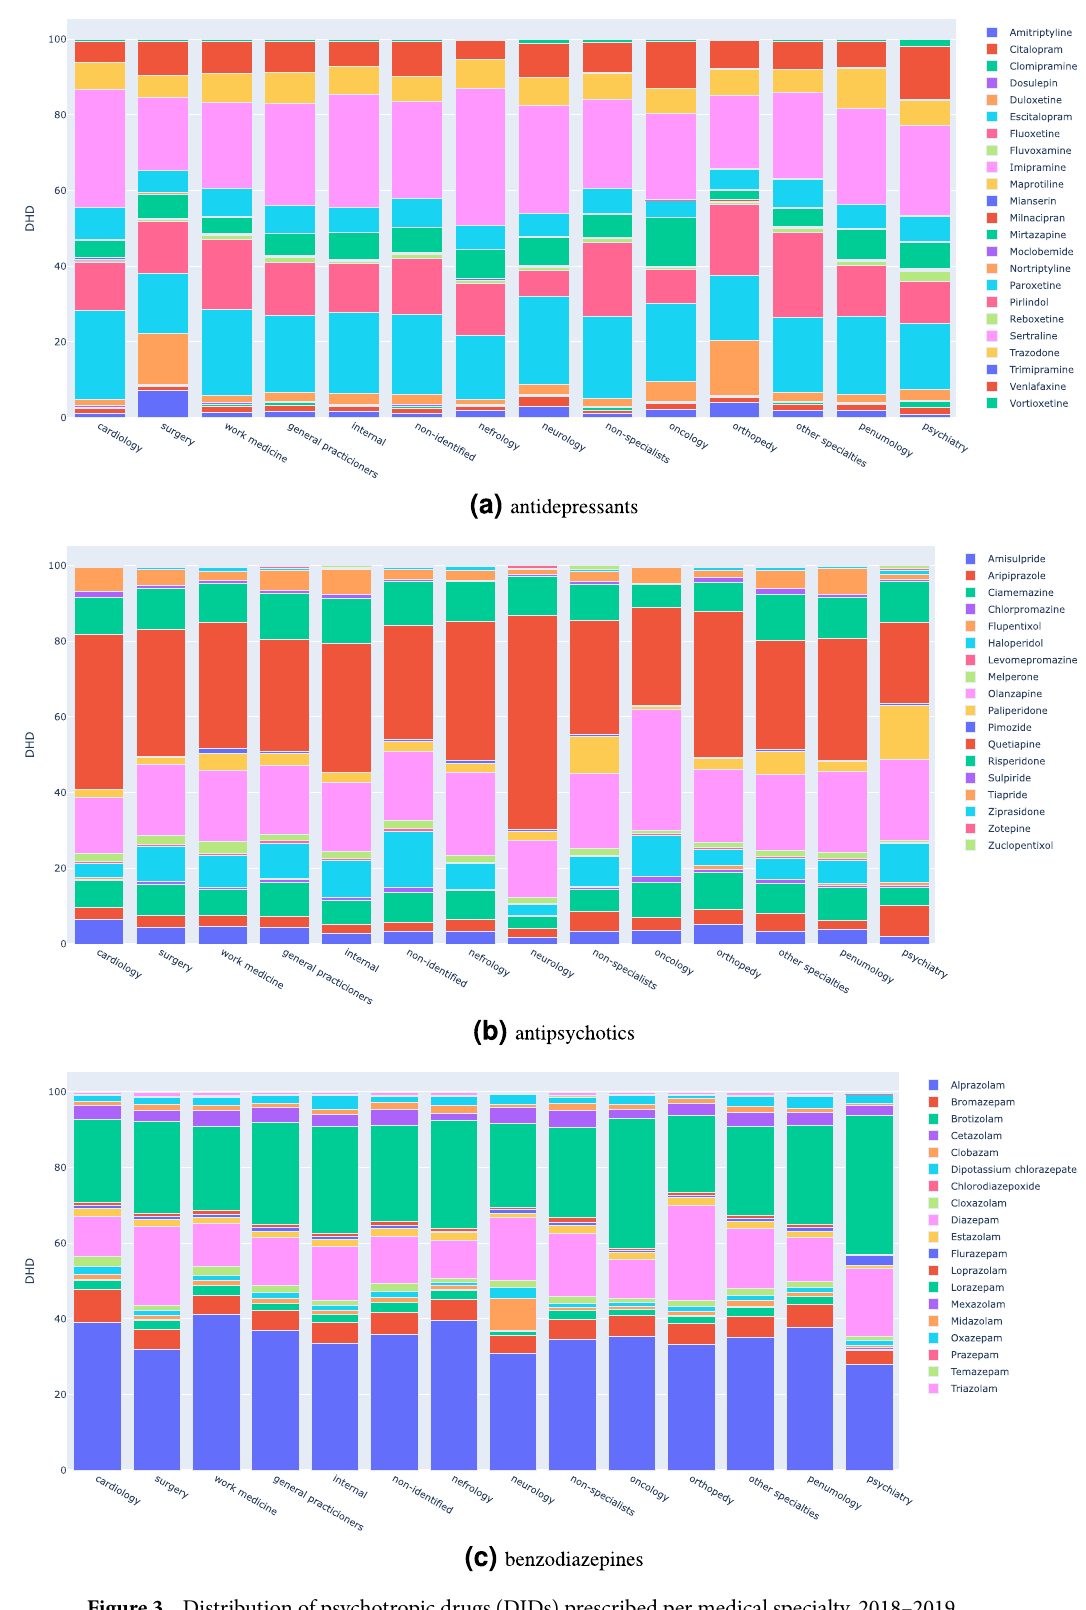
Figure 3. Distribution of psychotropic drugs (DIDs) prescribed per medical specialty,